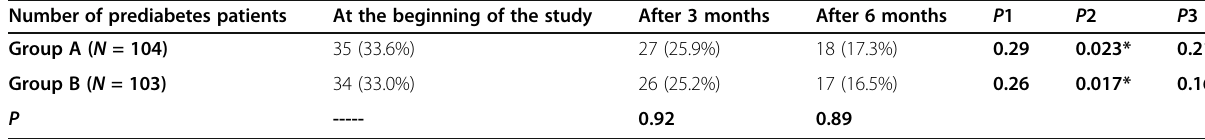
Table 4 Comparison of the number of prediabetic patients between the two studied groups Number of prediabetes patients At the beginning of the study After 3